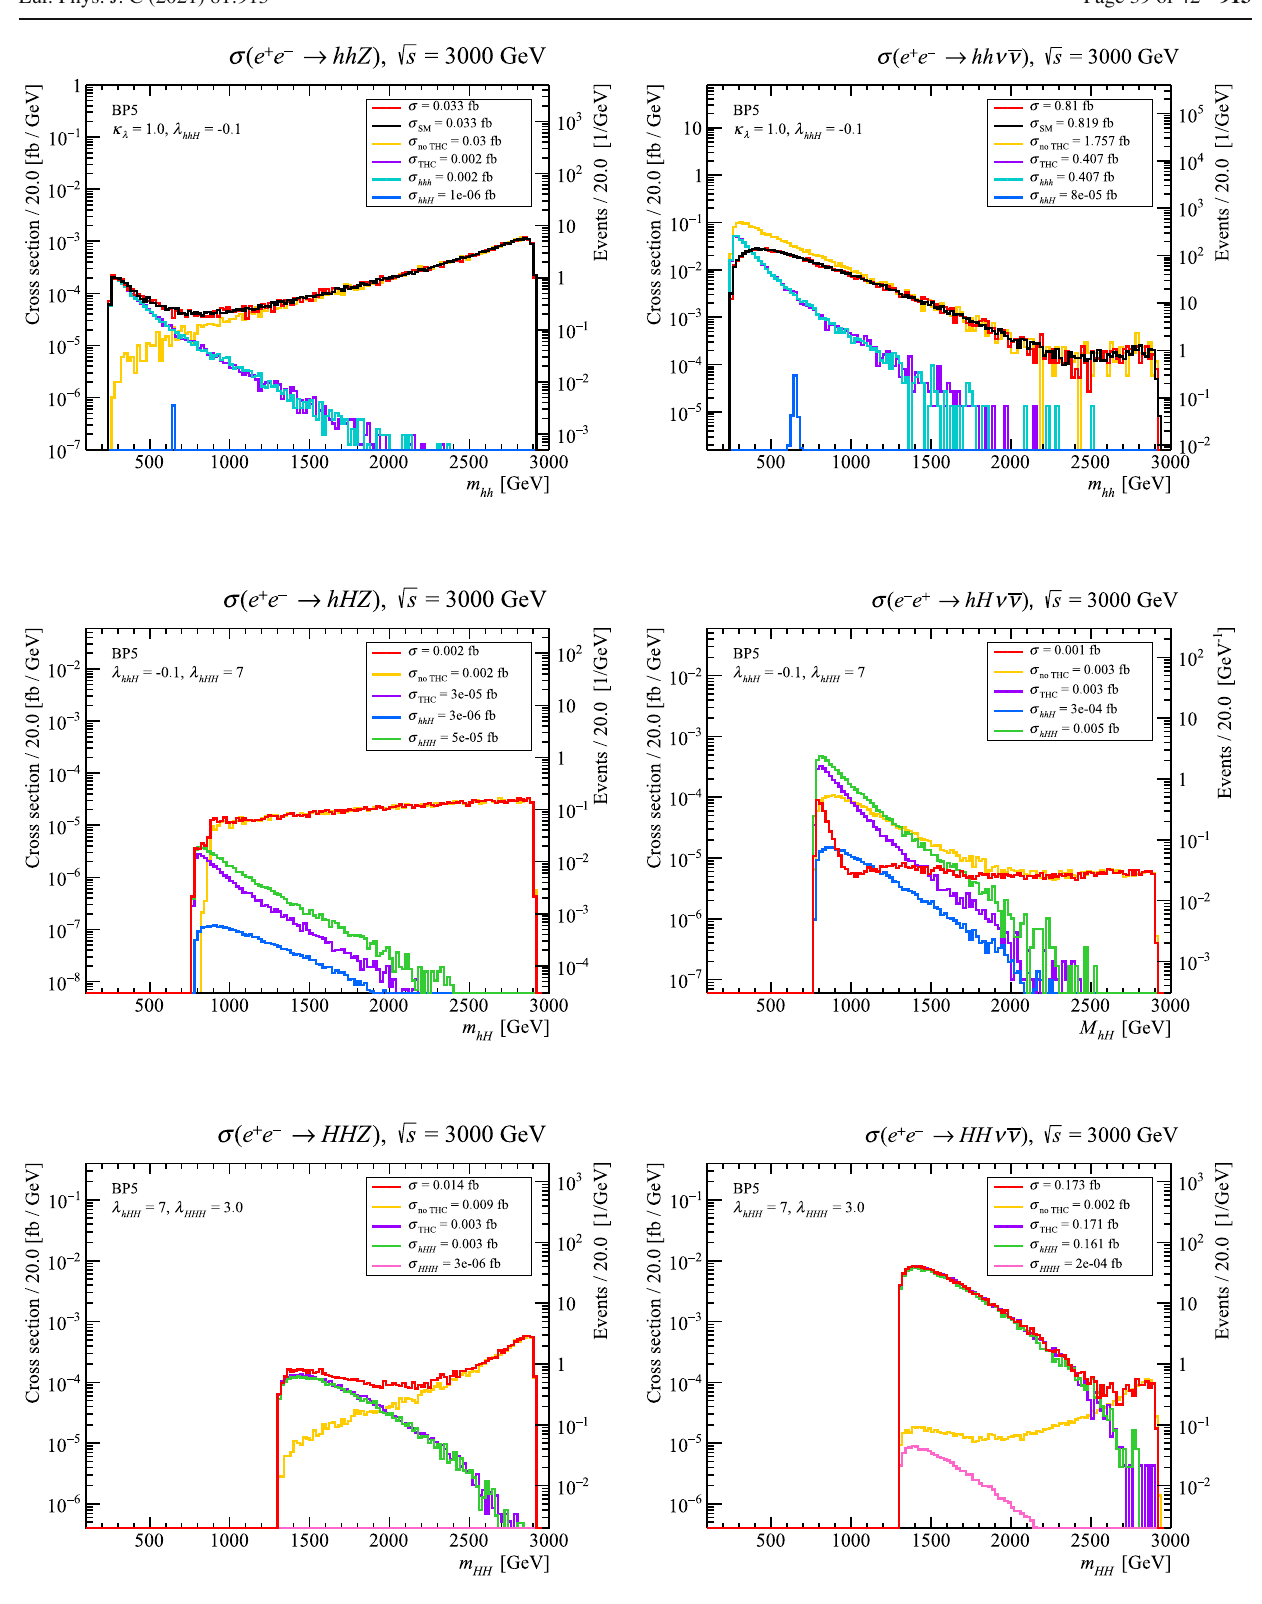
Fig. 29 Distribution on the invariant mass of the final h i h j pair in the process e + e − → h i h j Z (left column) and e + e − → h i h j ν ¯ ν (right column) √ s = 3000 GeV with h i h j = hh (upper row), h i h j = hH (middle row) and h i h j = H H (lower row) for BP5 (type at